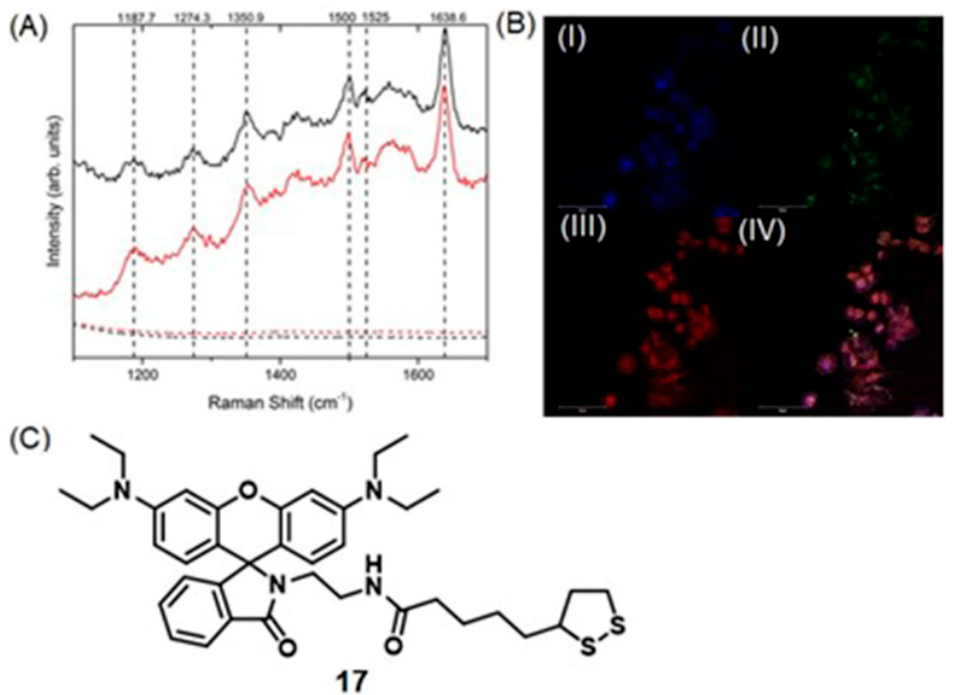
Figure 38. ( A ) Raman spectra of 17 (dashed lines) and gold nanoparticles functionalized with 17 (solid lines) at low pH (red) and high pH (black). ( B ) Co-localization of gold nanoparticles functionalized with 17 in A2780 cells visualized via confocal microscopy. (I) Lysotracker staining, (II) gold nanoparticles functionalized with 17 , (III) Mitotracker staining, and (IV) overlay (298 K). ( C ) Chemical structure of 17 . Adapted with permission from Eling, C. J.; Price, T. W.; Marshall, A. R. L.; Viscomi, F. N.; Robinson, P.; Firth, G.; Adawi, A. M.; Bouillard, J.-S. G.; Stasiuk, G. J. ChemPlusChem , John Wiley and Sons [344].